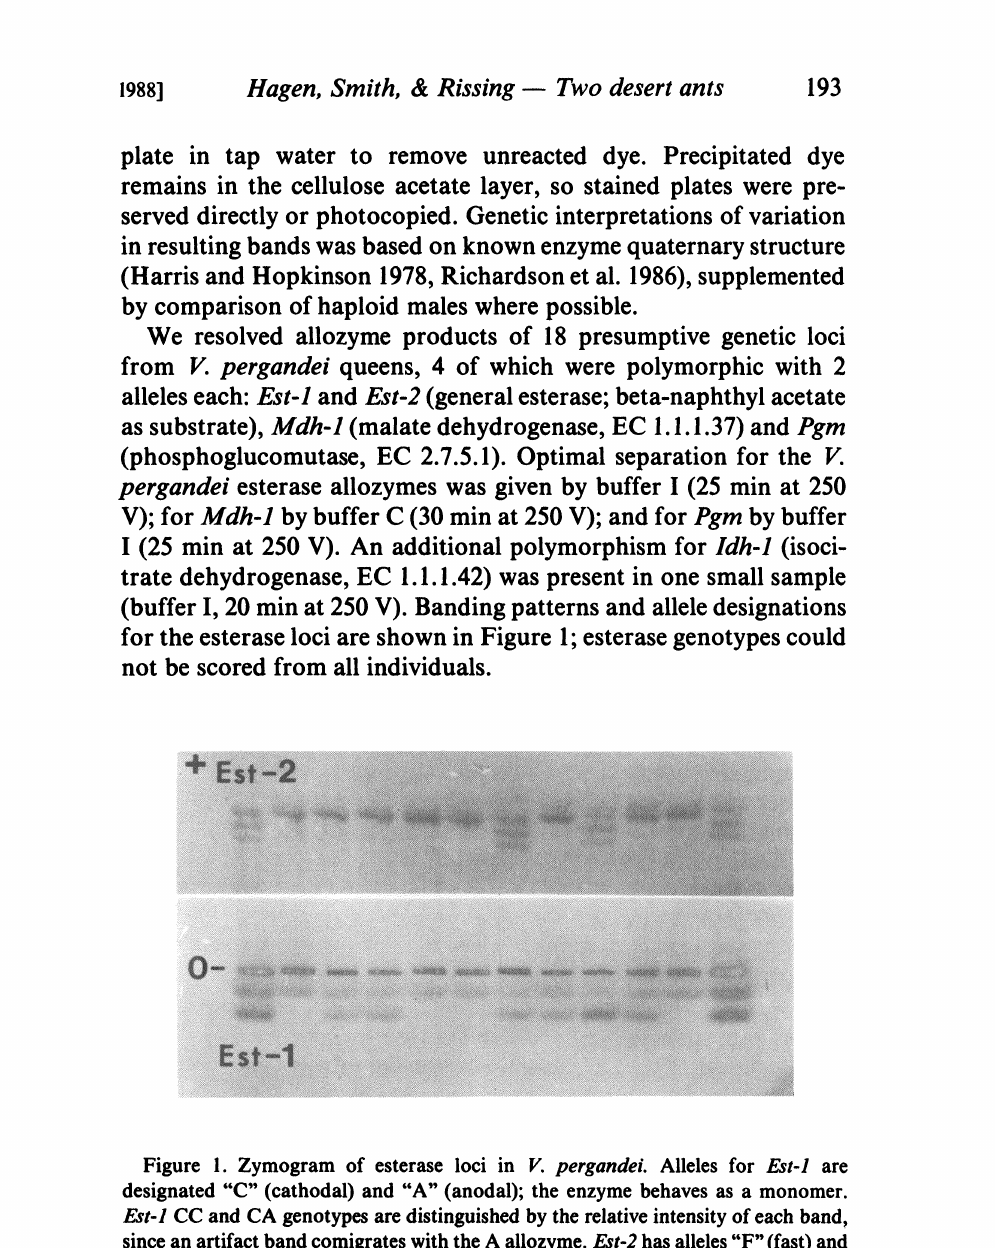
Figure 1. Zymogram of esterase loci in V. pergandei. Alleles for Est-1